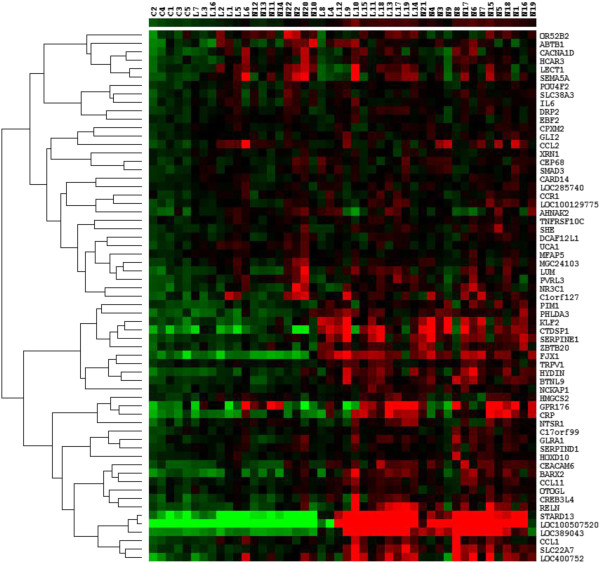
Rapamycin-regulated genes differentially expressed in both mild and advanced AD. Heat map of the 65 rapamycin-regulated genes that were shown to be differentially expressed in both mild and advanced AD compared to control, in separate two-class unpaired SAM analyses. The cut-off point for differential expression was <10% FDR. The heat map was generated with Cluster and Treeview, with complete hierarchical clustering by gene and array. The expression level of each gene relative to the median expression of the gene across all samples is represented on a red-green colour scale. The colours represent the log ratio of gene expression in an individual patient. Downregulated genes are represented in green (saturated green: log ratios −3.0 and below) while upregulated genes are represented in red (saturated red: log ratios 3.0 and above). Cells with log ratios of 0 (gene expression unchanged) are black. The arrays are identified by the patient codes that are described in Additional file 2: Table S1 (C: Control, L: Limbic stage AD, N: Neocortical stage AD) while the genes are identified by the gene name.